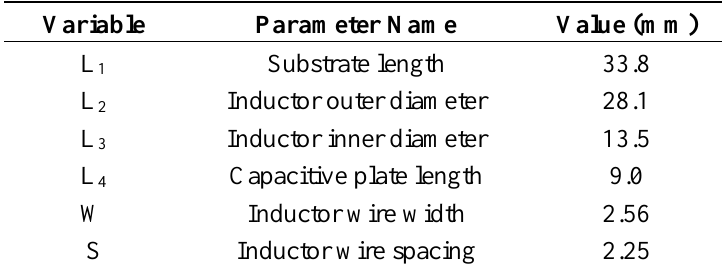
Figure 2. Fabricated pressure sensor. Table 1. Main dimensions of the fabricated pressure